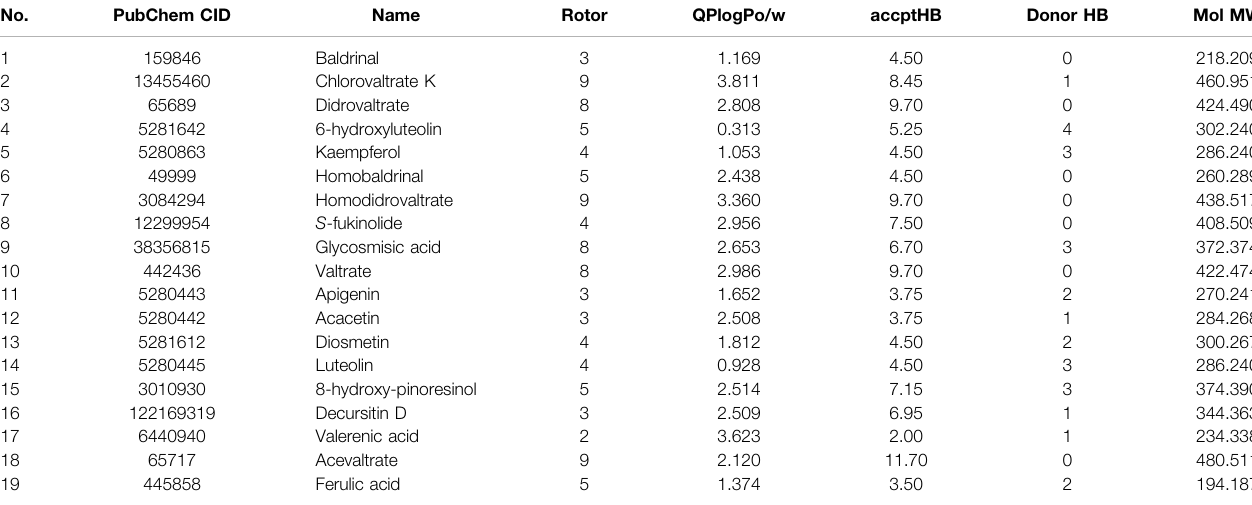
TABLE 2 | Information of the main active ingredients in Valeriana jatamansi Jones ex Roxb. No. PubChem